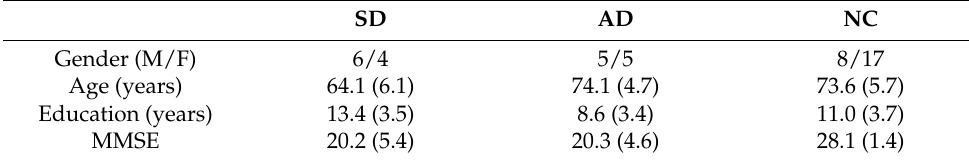
Table 1. Mean (SD) of the demographic features across the experimental groups. SD AD NC Gender (M/F)